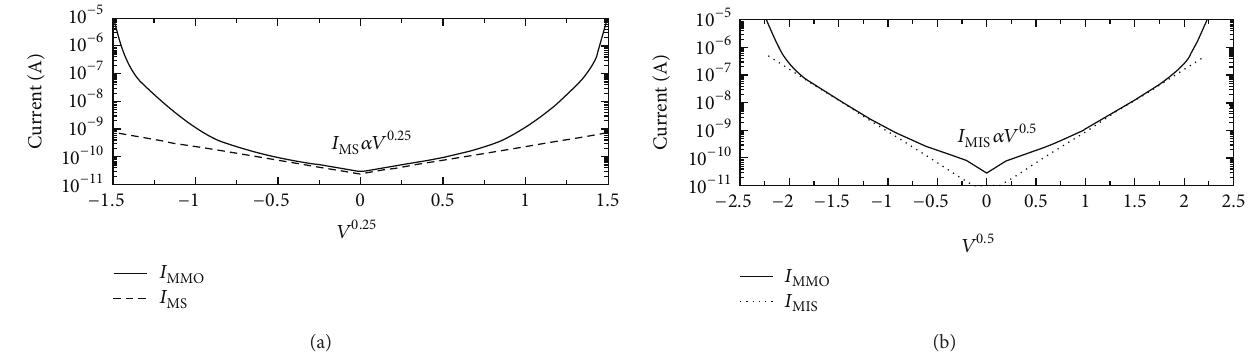
Figure 3: Current of Pd-mixture-GaAs MSM diodes as a function of (a) 𝑉 0.25 with 𝐼